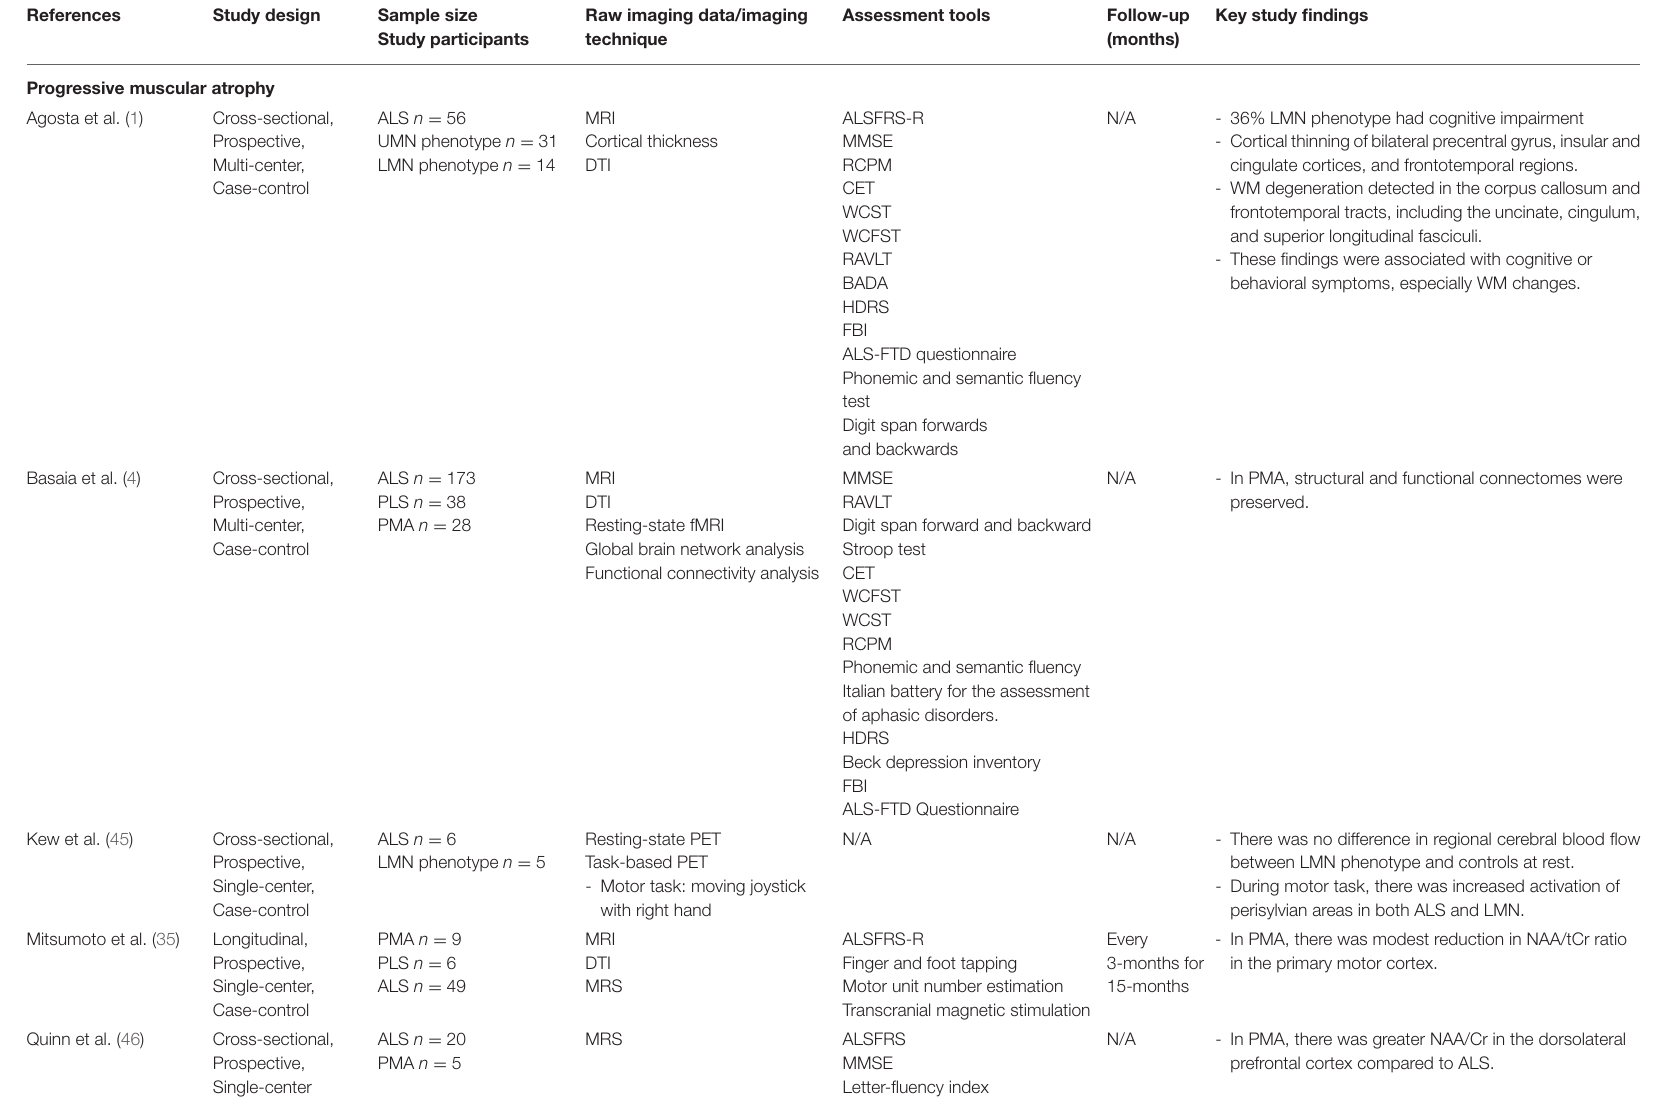
TABLE 3 | Selection of original neuroimaging research articles in PMA, SMA, SBMA, PPS, and